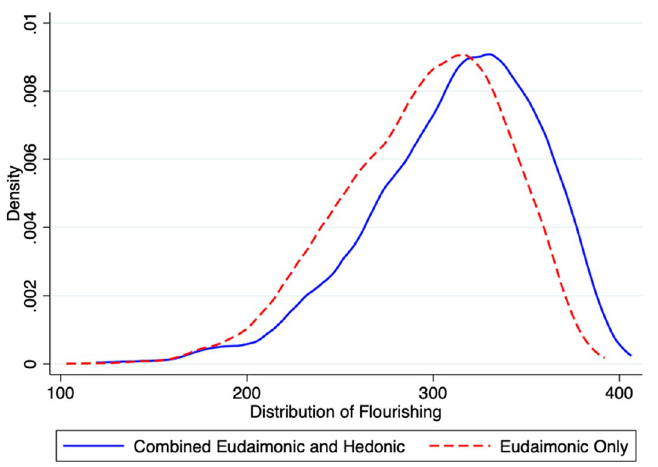
Figure 2. Distribution of Flourishing (Continuous